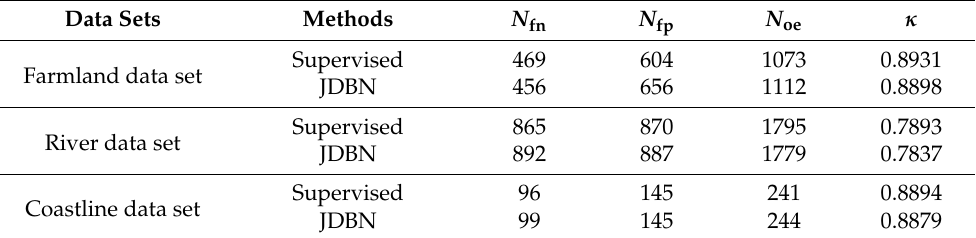
Table 1. Quantitative evaluation of the three data sets.